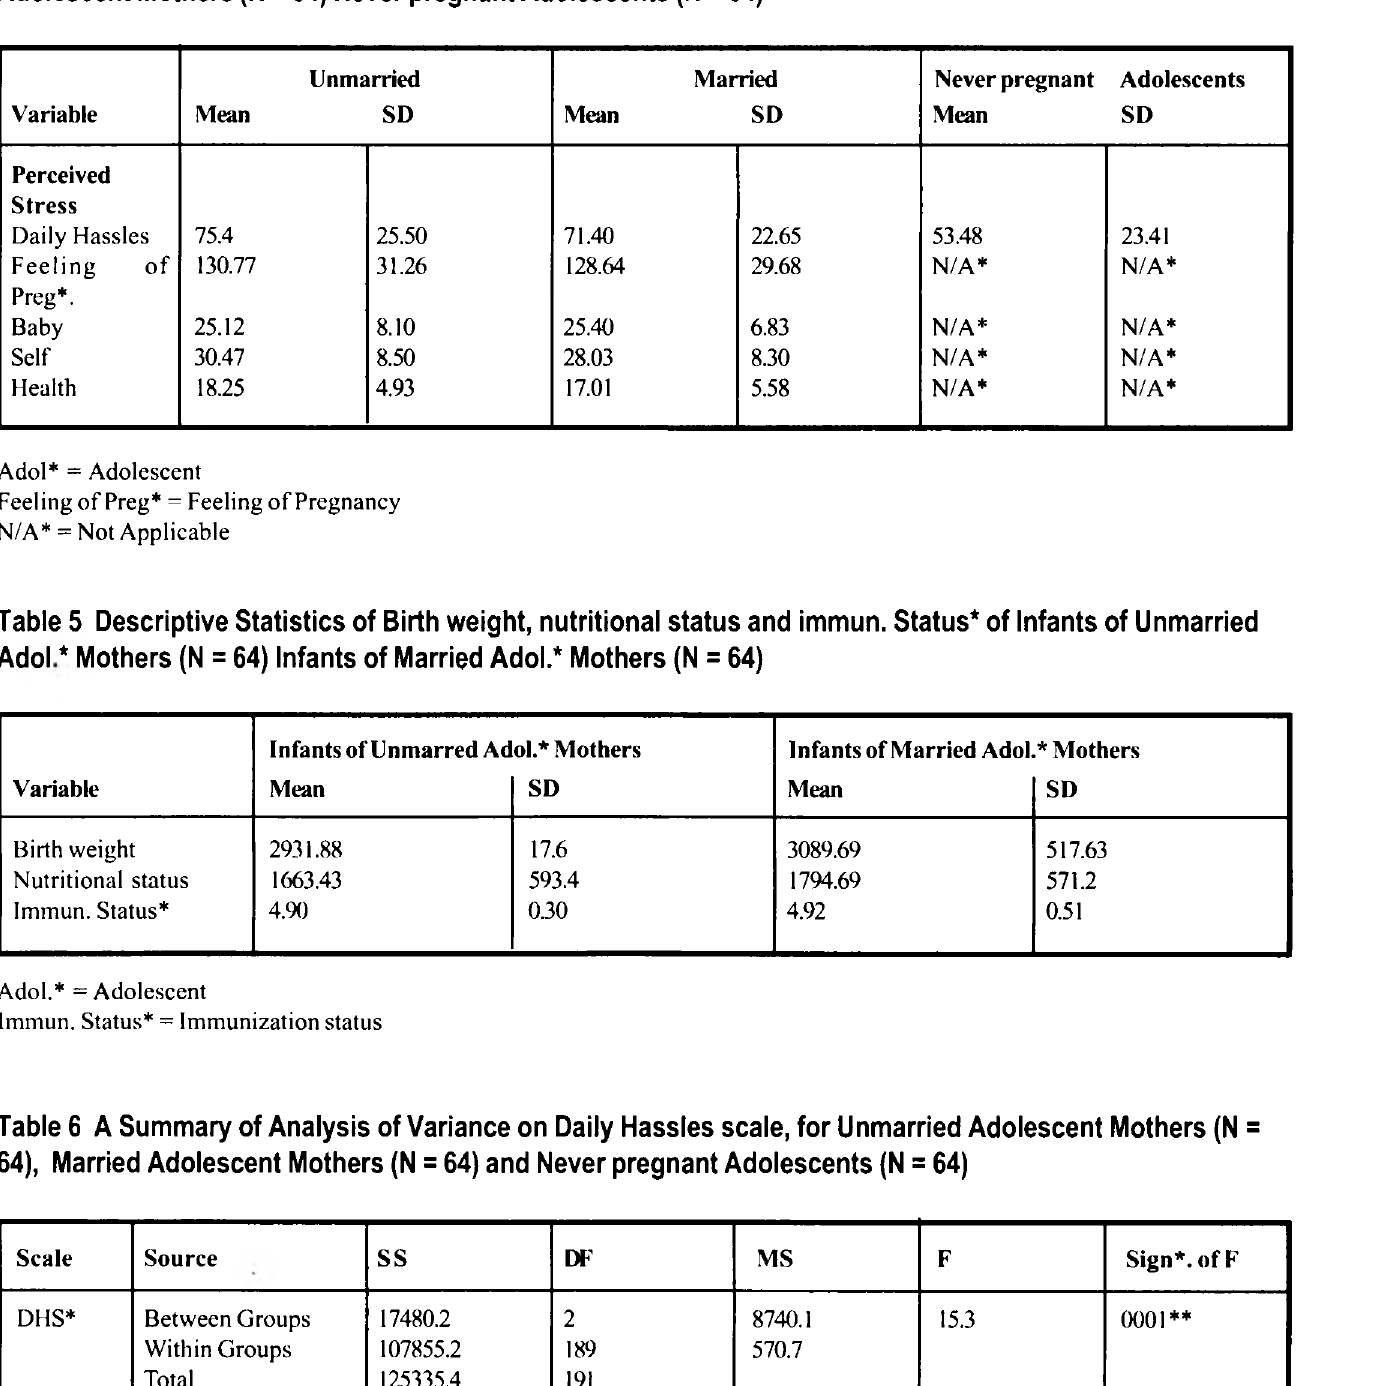
Table 4 Descriptive Statistics for Perceived Stress Among Unmarried Adolescent Mothers (N = 64) Married Adolescent Mothers (N = 64) Never pregnant Adolescents (N = 64)